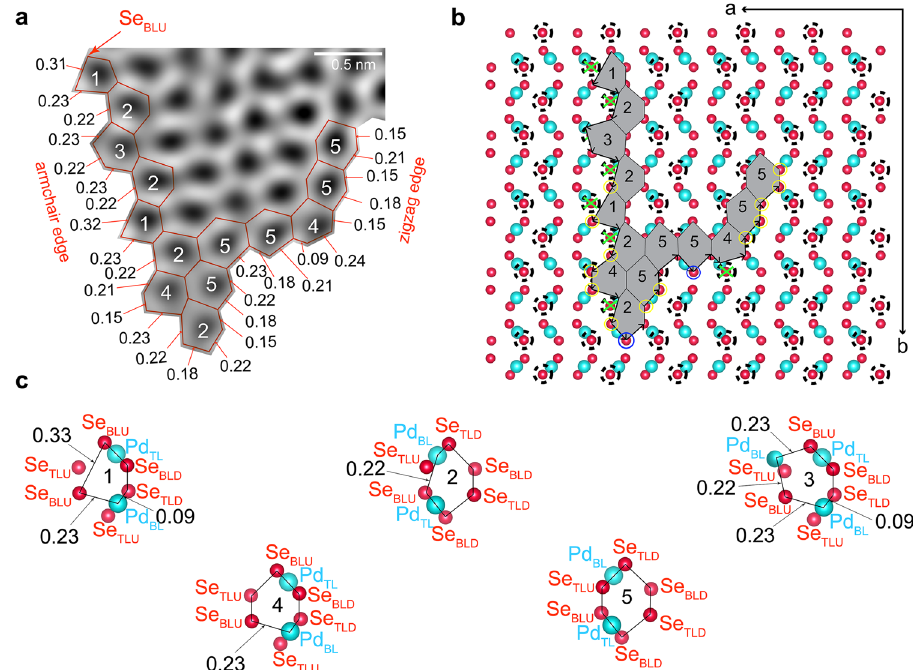
Fig. 3 Edge construction of dendritic PdSe 2 edge. a High-resolution TEM image of 2L PdSe 2 dendrites with measured edges in nanometers. b Theoretical model showing edge geometry of 2L dendritic PdSe 2 , where black circles encircling the Se atoms denotes Se TLU , yellow circle encircling Se denotes one side non-bonded Se – Pd, blue circle encircling Se are Se adatoms, green cross mark denotes excluded Se TLU from the followed path. c Theoretically calculated interatomic distance (in nm), which matches well with the experimentally obtained interatomic distance from